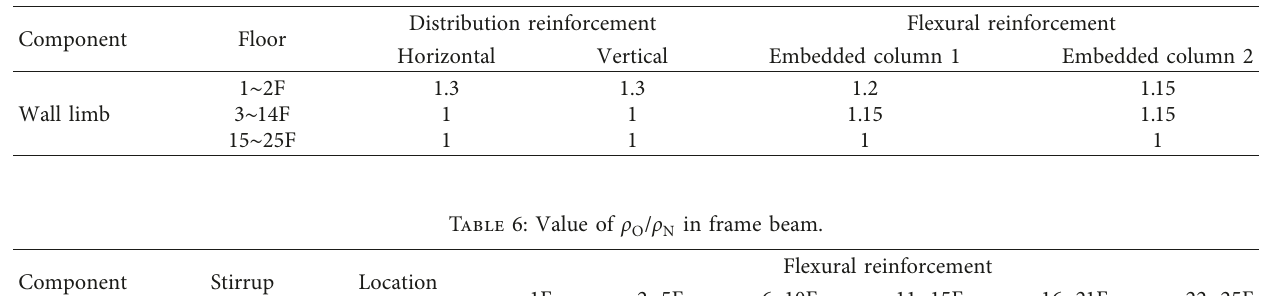
Table 5: Value of ρ